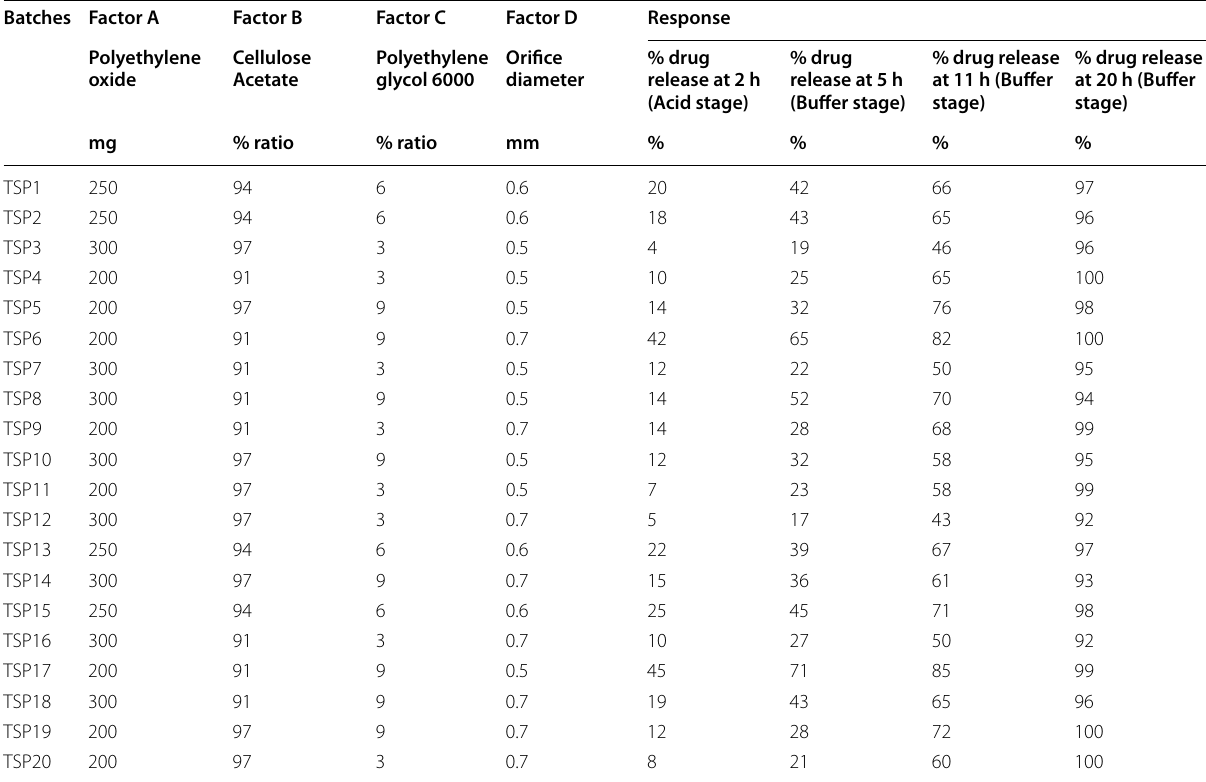
% Drug release values are expressed as mean where, n